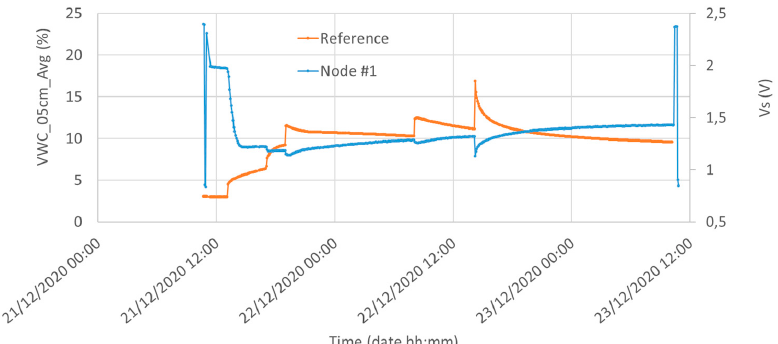
Figure 16. Water content measured by the reference system (orange, 5 cm underground) and the Capacitive Soil Moisture Sensor v1.2 (blue) in Loamy Sand. Initial and final peaks of the Node #1 plot represent a calibration of the Capacitive Soil Moisture Sensor v1.2 obtained by placing the sensor for 15 min in the air (maximum peak) and 15 min in water (minimum peak).